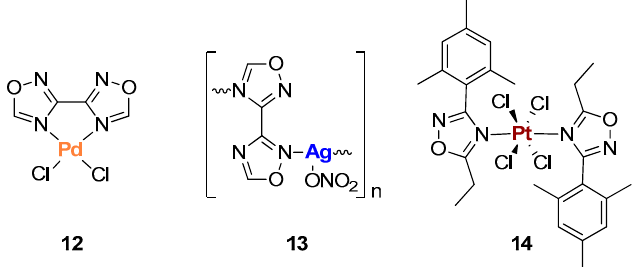
Figure 6. Structures of metal complexes with ligand bearing the 1,2,4-oxadiazole scaffold.